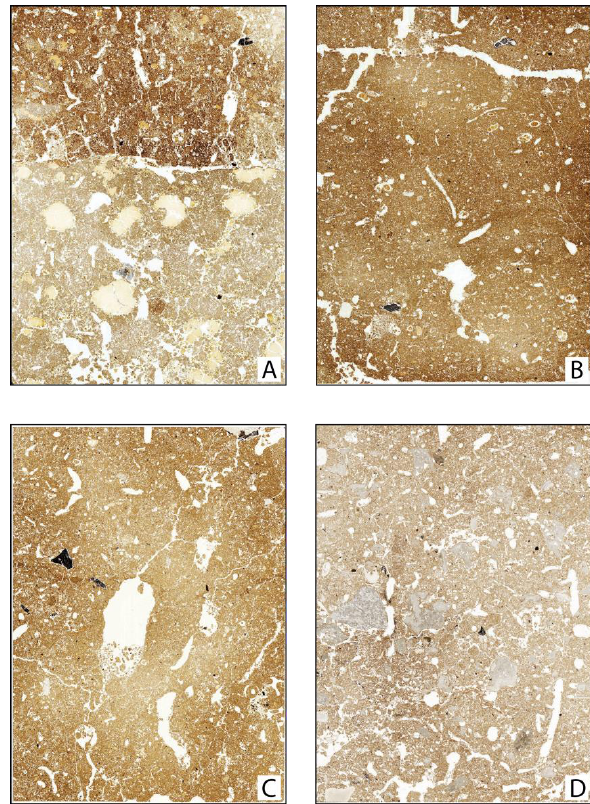
Figure 9: Flatbed scans of selected thin sections prepared from the sequence at Arbreda cave. 2 Figure 9. Flatbed scans of selected thin sections prepared from the sequence at Arbreda Cave. (A) CA-MM1 contains the sharp ero- A) CA-MM1 contains the sharp erosional contact between archaeological levels J and I 3 sional contact between archaeological levels J and I equivalent to equivalent to sediment units B.1.2.2 and B.2.1.1. The difference in groundmass colour and 4 sediment units B.1.2.2 and B.2.1.1. The difference in groundmass colour and between types and sizes of phosphate infillings is clearly between types and sizes of phosphate infillings is clearly visible. B) CA-MM-2.1 from 5 visible. (B) CA-MM2.1 from sediment unit B1.2.2, (C) CA-MM2.4 sediment unit B1.2.2, C) CA-MM2.4 from sediment unit B1.2.1 and D) CA-MM7 from 6 from sediment unit B1.2.1 and (D) CA-MM7 from sediment unit B.1.1. The frame width equals 6cm. (Further explanations see text.)